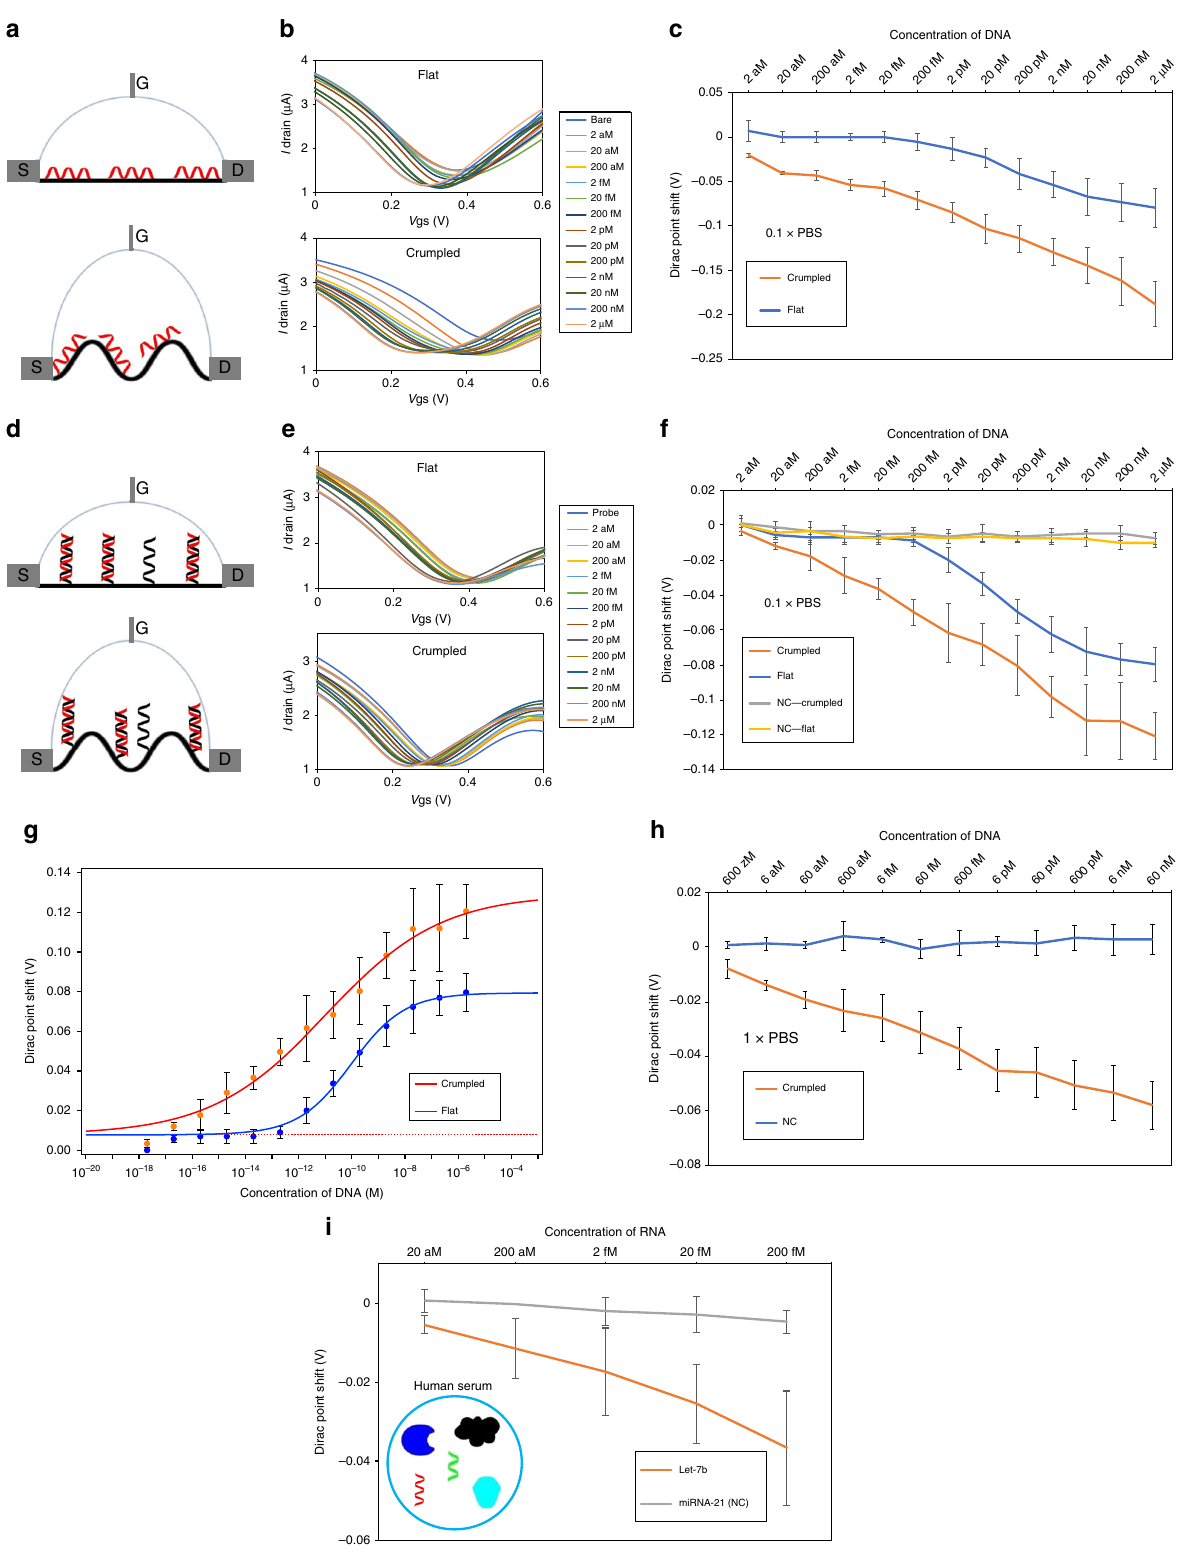
Origin of Dirac shift . To investigate the phenomena underlying the experimental results and the effect of ionic screening of DNA molecules, we studied the electrostatics and charge distribution of DNA and ions near fl at and deformed graphene surfaces using